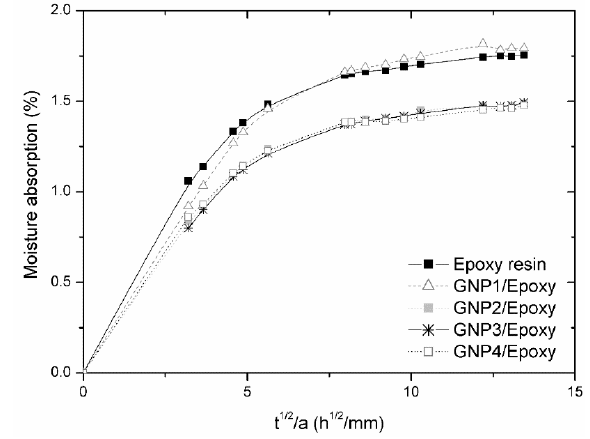
Figure 4. Moisture absorption of neat epoxy resin and epoxy composites reinforced with different types of graphene, commercially named GNP1, GNP2, GNP3 and GNP4, were t is time, and a is area.